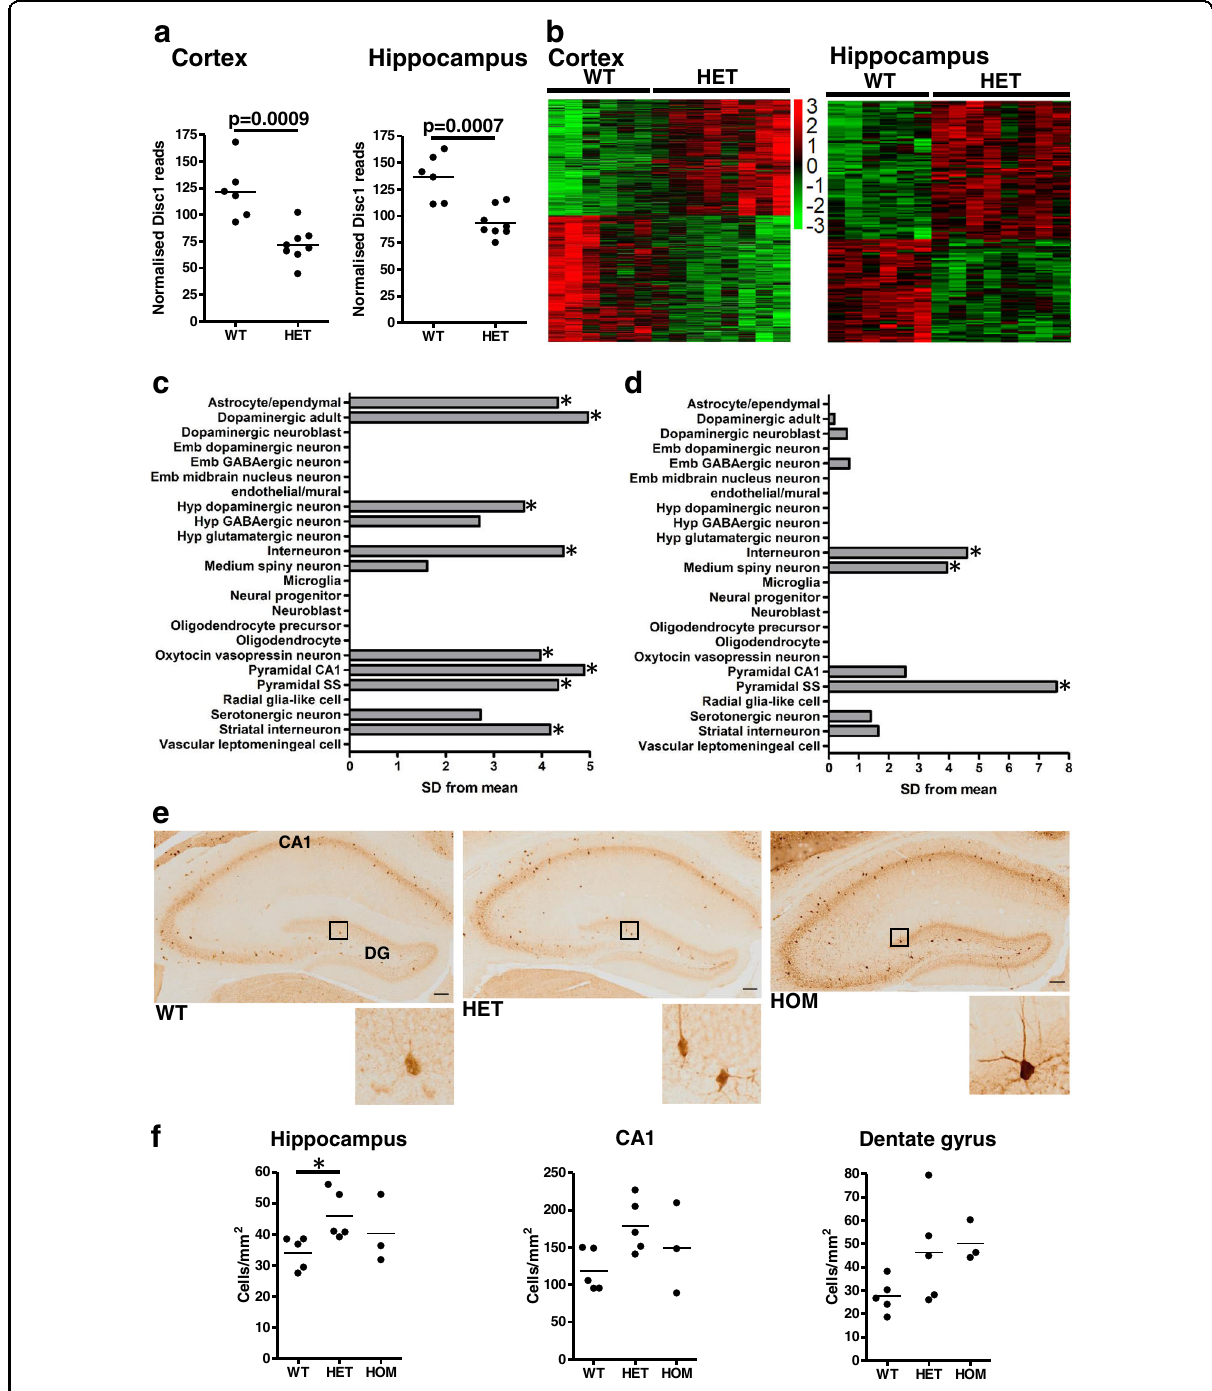
Fig. 1 The Der1 mutation targets speci fi c cell types in heterozygous cortex and hippocampus. a Disc1 RNASeq reads normalised to total reads per sample in wild-type versus heterozygous Der1 cortex and hippocampus. b Heat maps of the top 500 dysregulated genes identi fi ed by RNASeq of wild-type versus heterozygous Der1 cortex and hippocampus. c , d EWCE analysis of heterozygous Der1 cortex and hippocampus, respectively, in mouse brain cell classes. Asterisk, signi fi cance after Bonferroni correction; Emb embryonic, Hyp hypothalamic, SD standard deviation. e Parvalbumin expression in hippocampal sections from 9-week-old mouse brain. Enlarged regions showing parvalbumin-expressing interneurons are indicated by boxes. Scale bars, 100 μ m. f Average density of parvalbumin-expressing interneurons. Hippocampus refers to the whole hippocampal formation. Data were analysed by Kruskal – Wallis one-way ANOVA, p = 0.07 for the dentate gyrus, p = 0.049 for the hippocampal formation. The horizontal line on graphs for each sample, an average of values; WT wild type, HET heterozygous Der1 , HOM homozygous Der1 , DG dentate gyrus, * p <